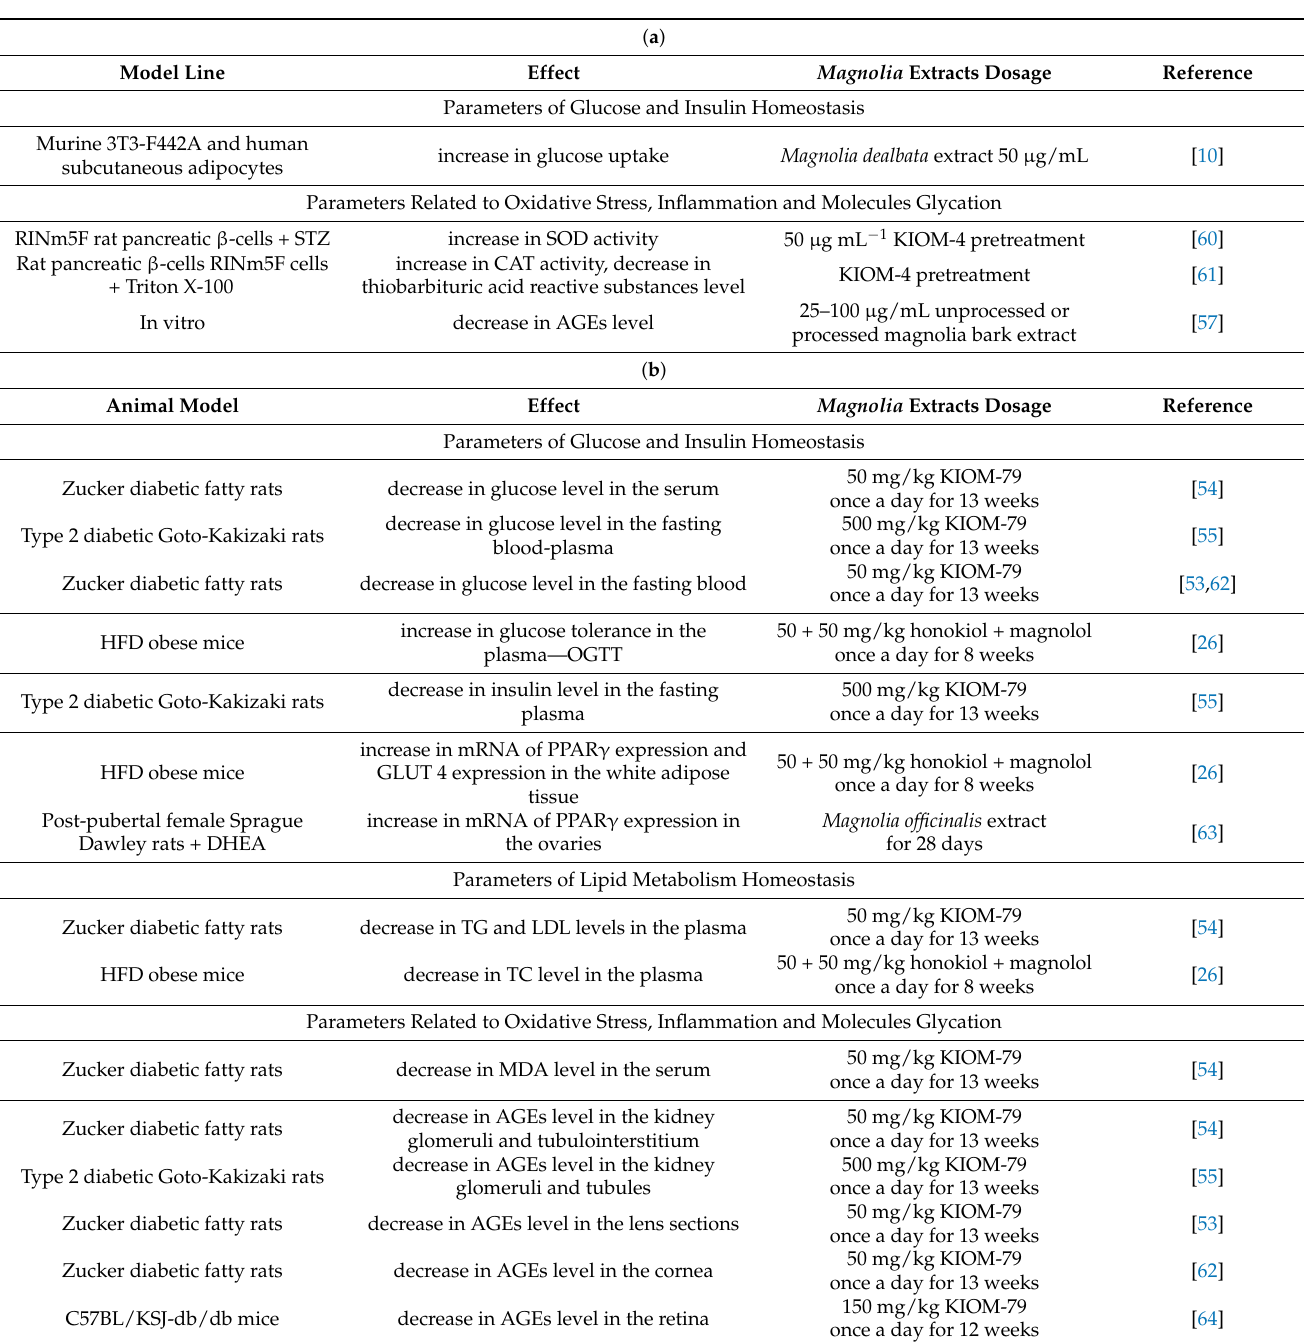
Table 3. ( a ) Antidiabetic activity and the effect of Magnolia extracts on the basic parameters of oxidative stress in in vitro studies. ( b ) Antidiabetic activity and the effect of Magnolia extracts on the basic parameters of oxidative stress and lipids in in vivo